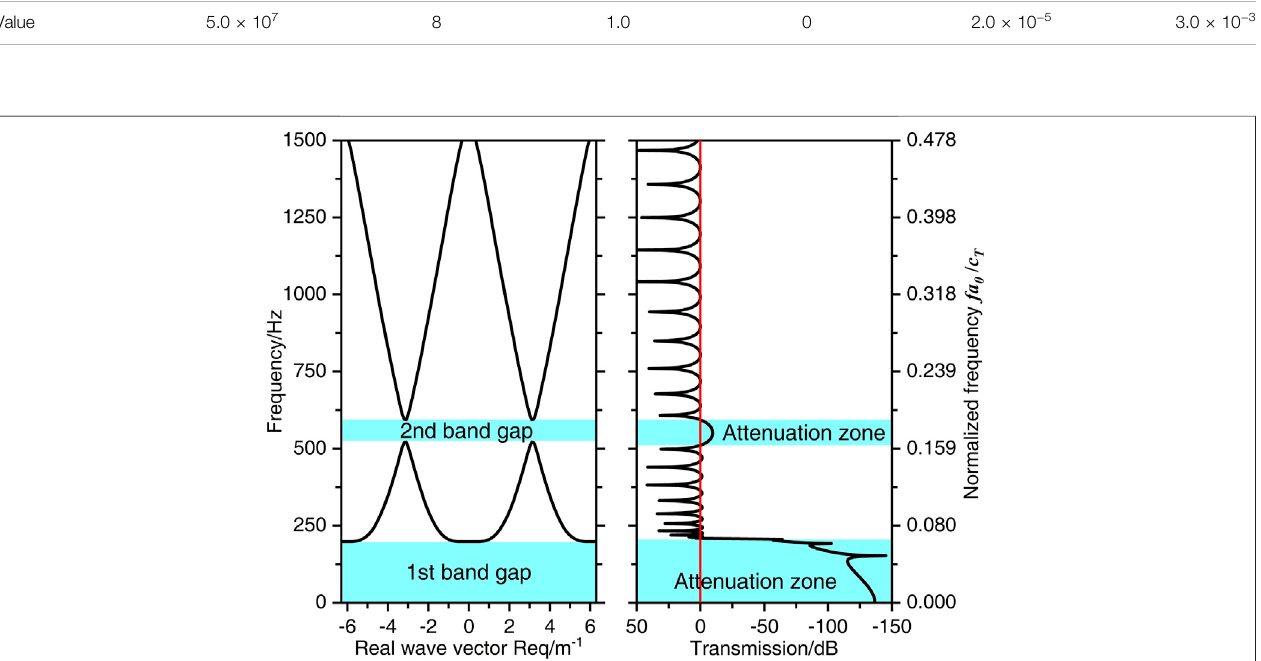
Frontiers in Materials |